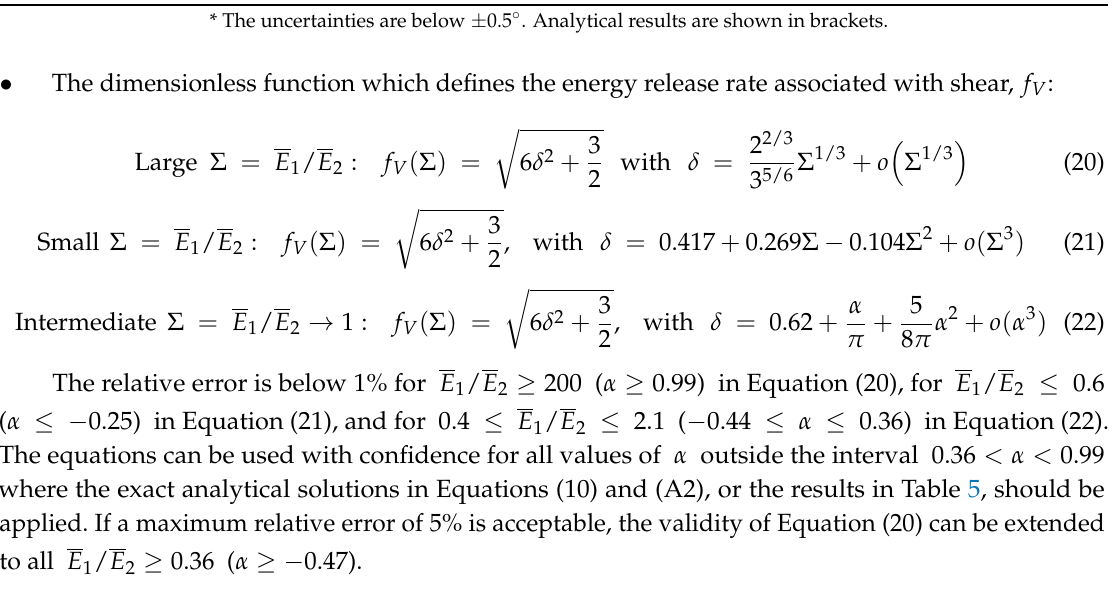
Table 5. The dimensionless function defining the energy release rate associated with the elementary shear load, Figure 1, with V (cid:54) = 0, P = M =